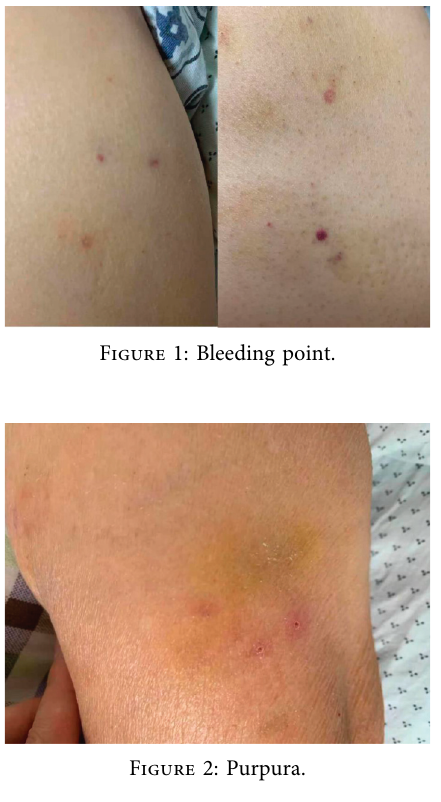
Figure 2: Purpura.